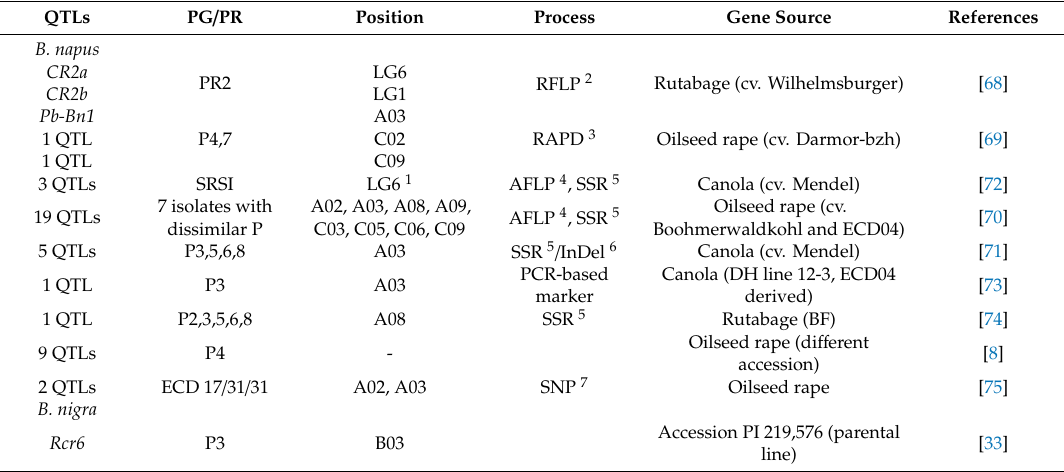
Table 3. CR loci reported on B. napus and B. nigra .